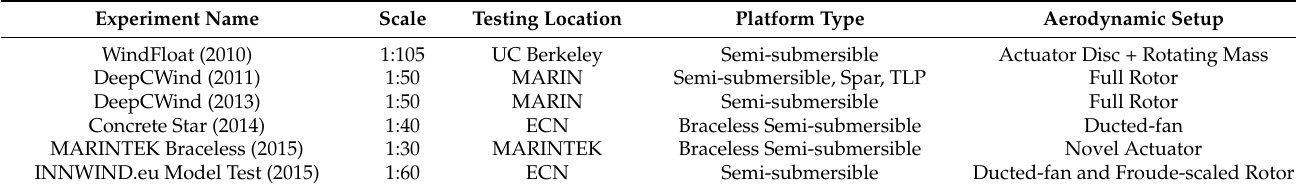
Table 2. Floating Offshore Wind Turbine Experiment